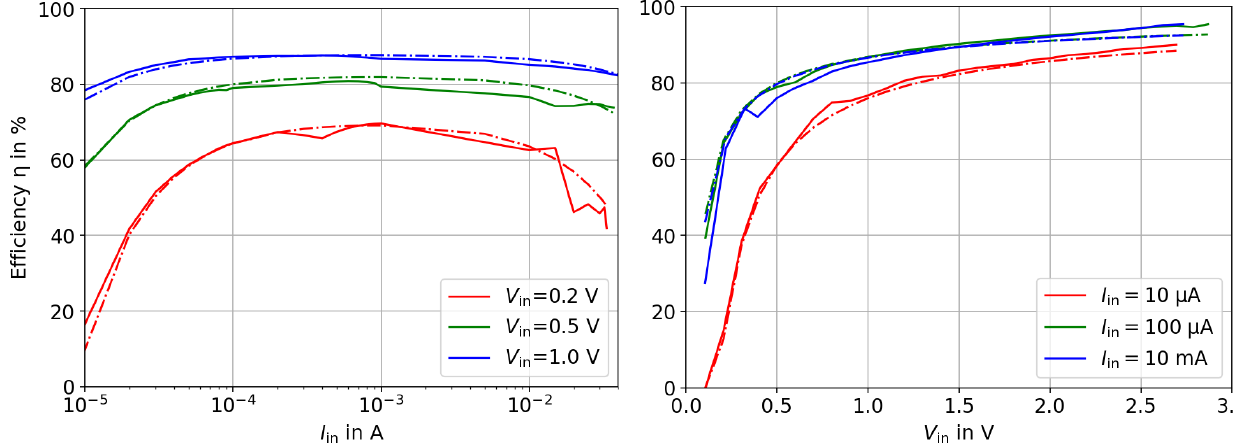
Figure 5. Efficiency w.r.t I in and V in of the ADP5090 boost converter. The output voltage V out is